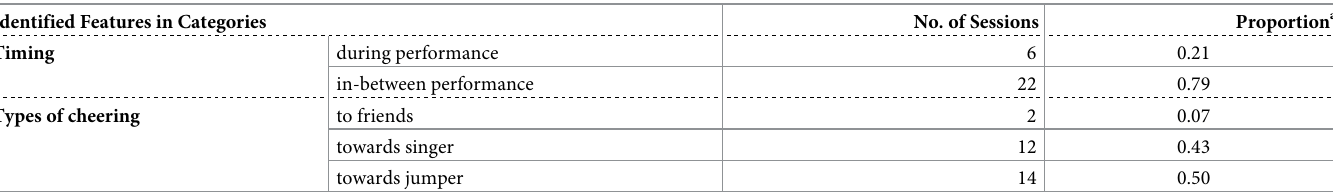
Table 4. Features of celebrations in adumu .